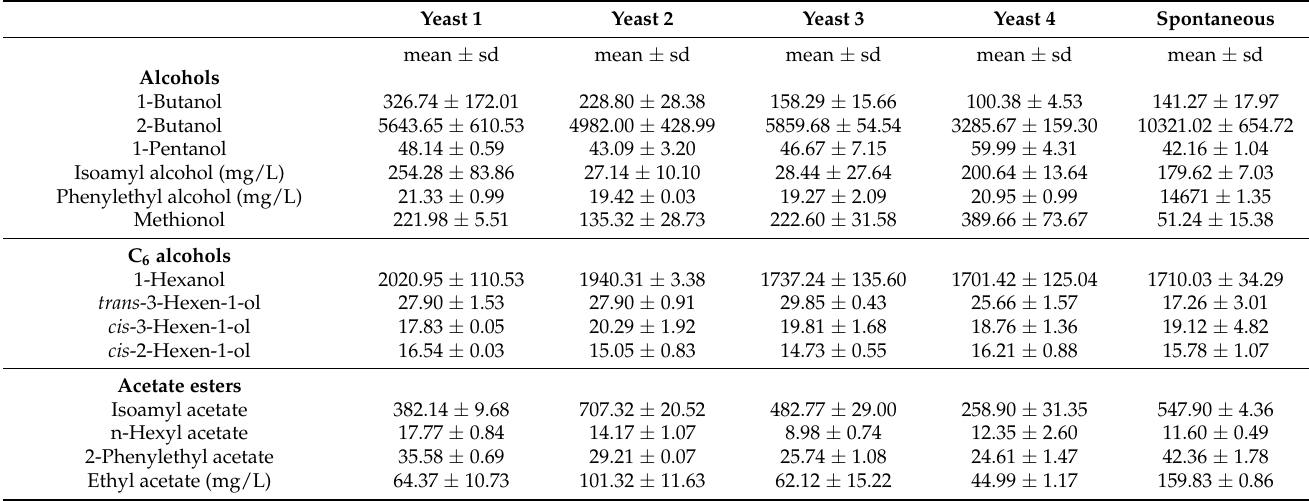
Table 5. Concentration ( µ g/L) of volatile compounds of Area 1 Corvinone withered